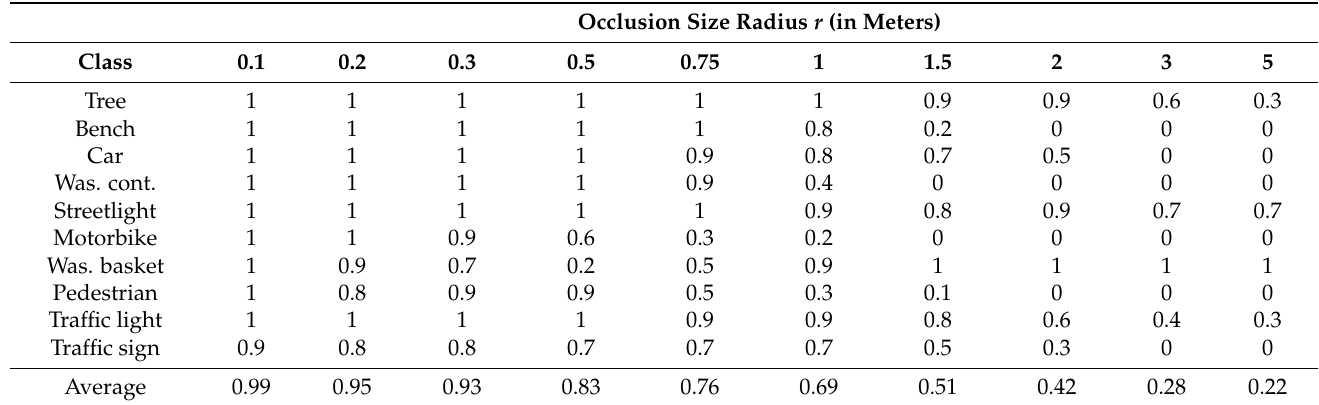
Table 9. Precision of classification with different occlusion sizes.